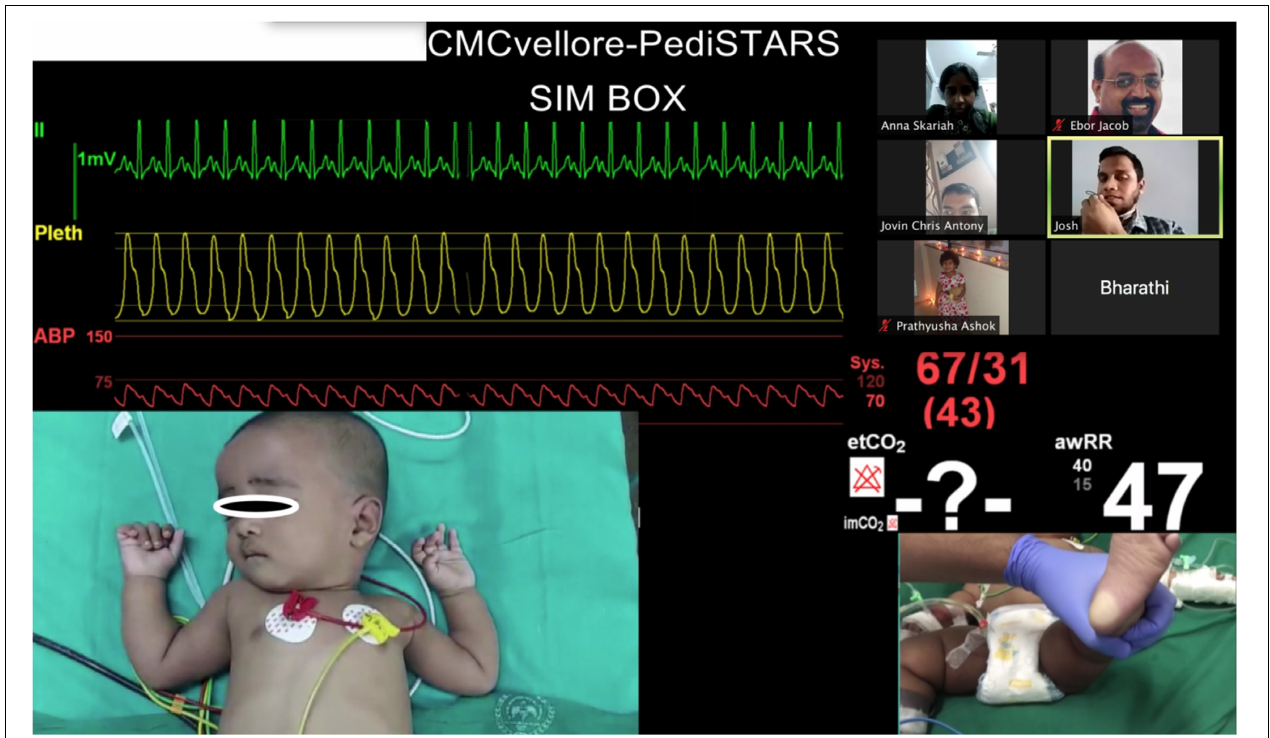
FIGURE 2 | Telesimulation session showing pictures of real patient video clips with participants and facilitators meeting on the video conferencing platform Zoom©.